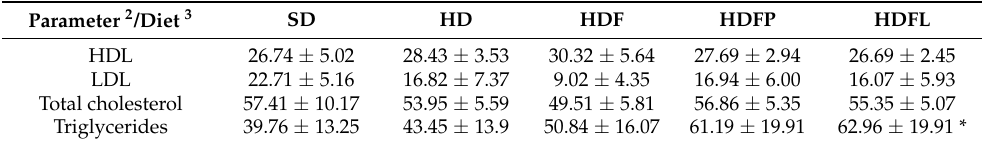
Table 2. Biochemical parameters after eight weeks of treatment (mg/dL) 1